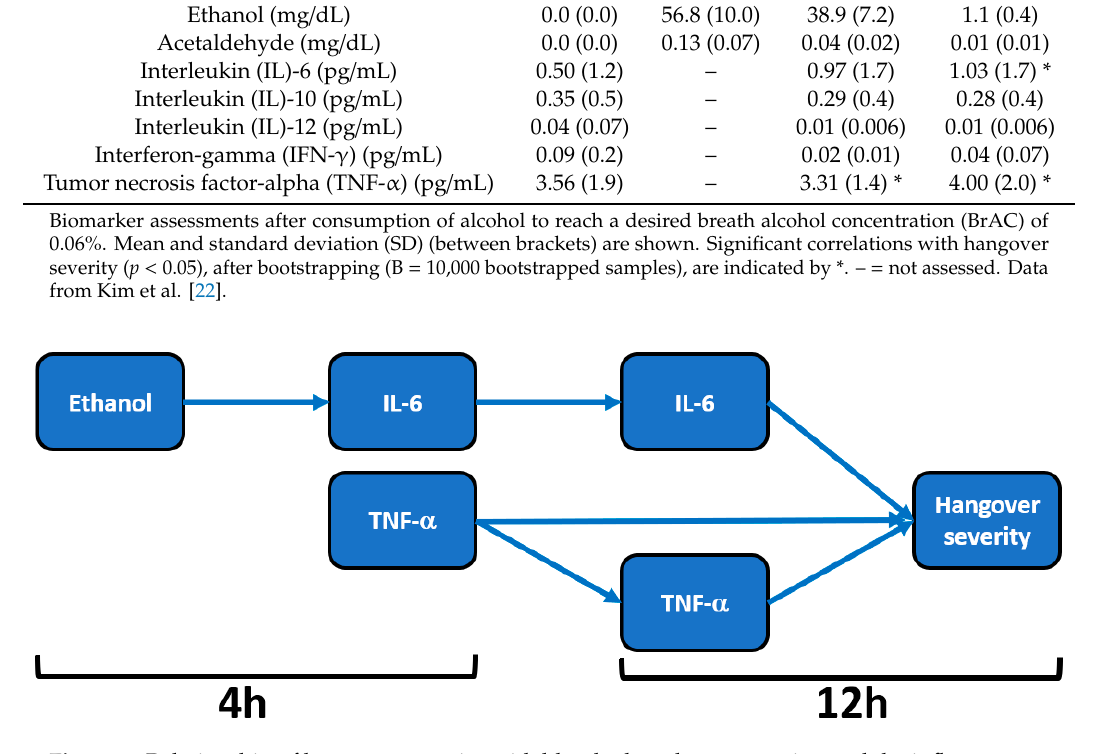
Figure 1. Relationship of hangover severity with blood ethanol concentration and the inflammatory response to alcohol. Note: Arrows represent significant correlations after bootstrapping. Abbreviations: Il = interleukin, TNF = tumor necrosis factor, h = hours after alcohol consumption. Data from Kim et al. [22].